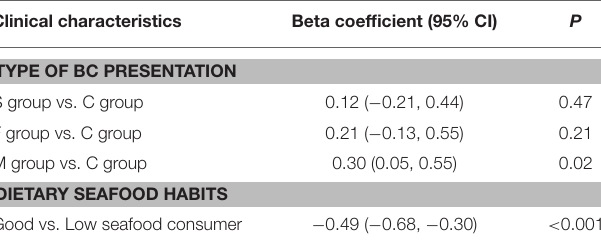
TABLE 3 | Multivariate regression models to predict variation of DHA levels in RBC membranes between baseline (T0) and after DHA supplementation (T1).